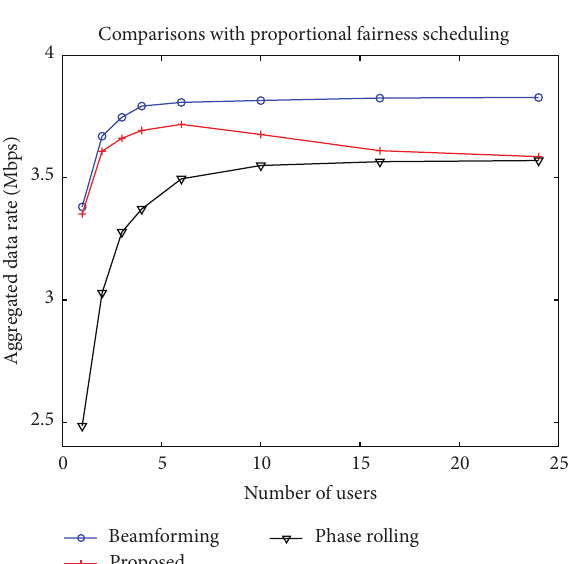
algorithm, where there is a greater chance that the same user is assigned to an RB over multiple consecutive time